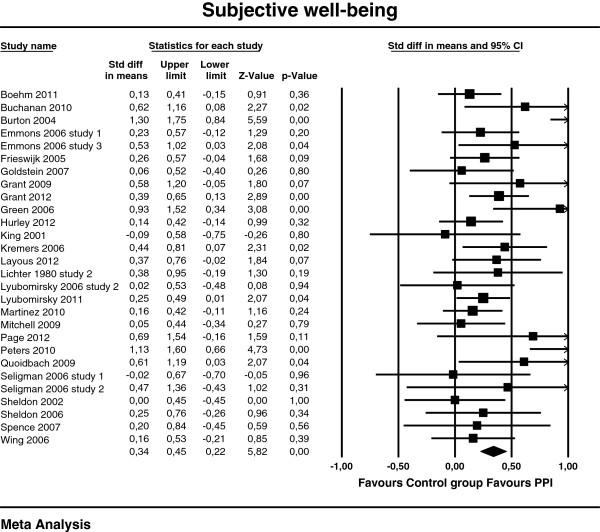
Post-test effects of positive psychology interventions on subjective well-being. The square boxes show effect size and sample size (the larger the box, the larger the sample size) in each study, and the line the 95% confidence interval. The diamond reflects the pooled effect size and the width of the 95% confidence interval.